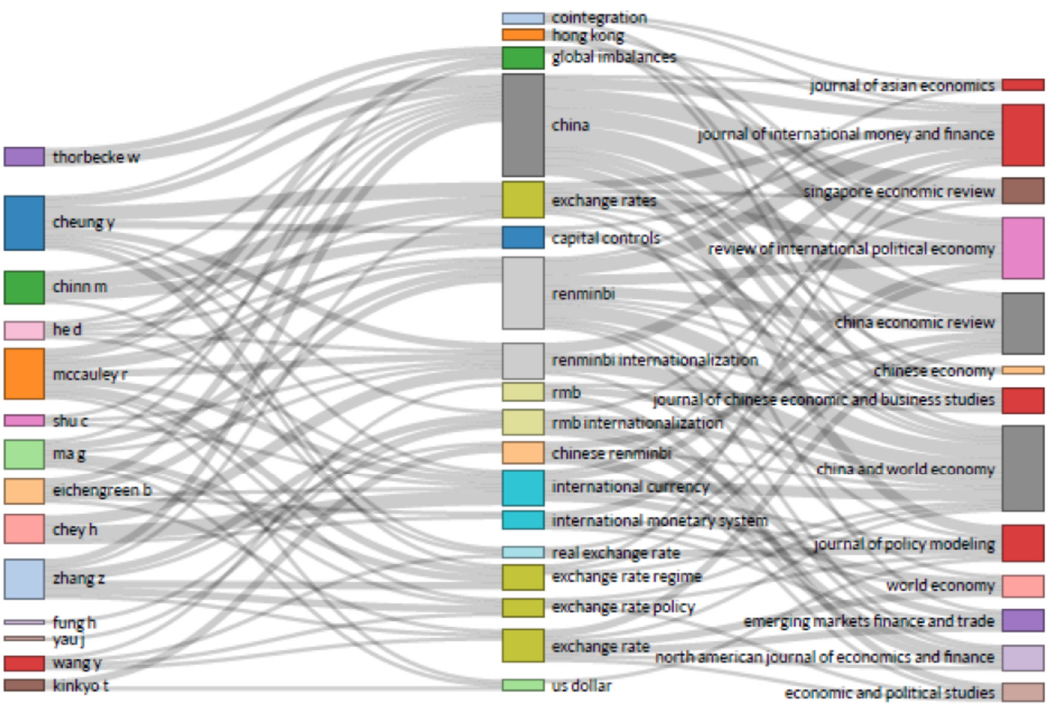
Figure 1. Three-fields plot (authors—authors’ keywords—sources). Source: Authors’ elaboration using Biblioshiny.